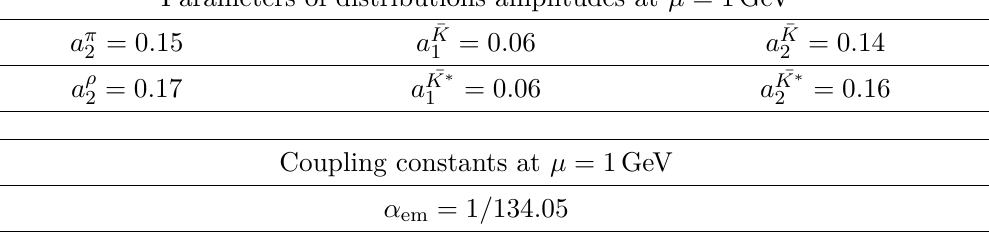
Table 1 . Inputs used to obtain QCD NNLO predictions and QED effects. The Gegenbauer coefficients of the π and K are taken from [13] and evolved to 1 GeV with LL accuracy. The ρ and K ∗ Gegenbauer coefficients are taken from [14], which uses Lattice QCD results from [15]. We use α (4) s with four flavours and the three-loop running, while the Wilson coefficients were matched to the full SM at the electroweak scale µ = m . The quark masses are to be understood as two-loop 0 W pole